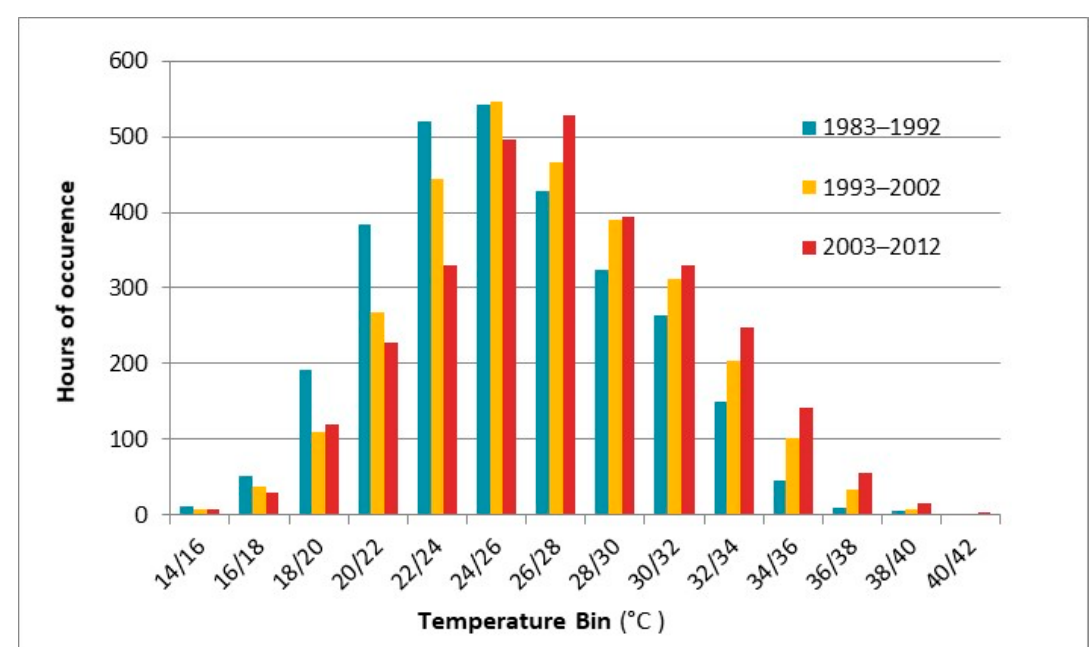
Figure 2. Temperature bin hours of occurrence in 2 ◦ C intervals. Athens (NOA) (cooling season—June to September).